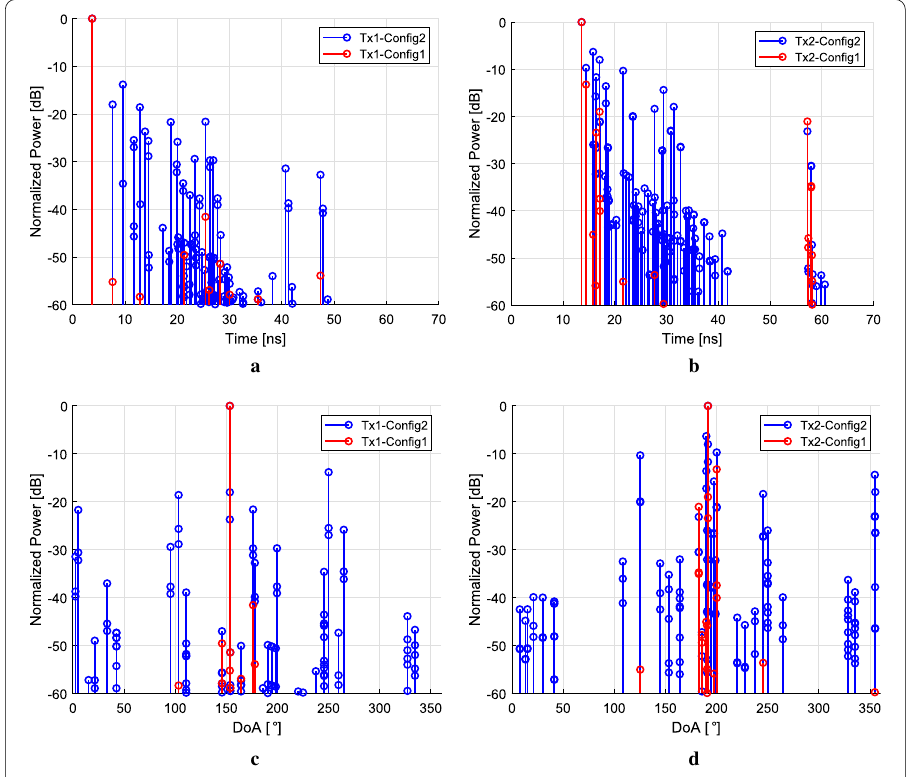
Fig. 8 Channel characteristics at Pos 3. a PDP with Tx1 configurations, b PDP with Tx2 configurations, c PAP with Tx1 configurations and d PAP with Tx2